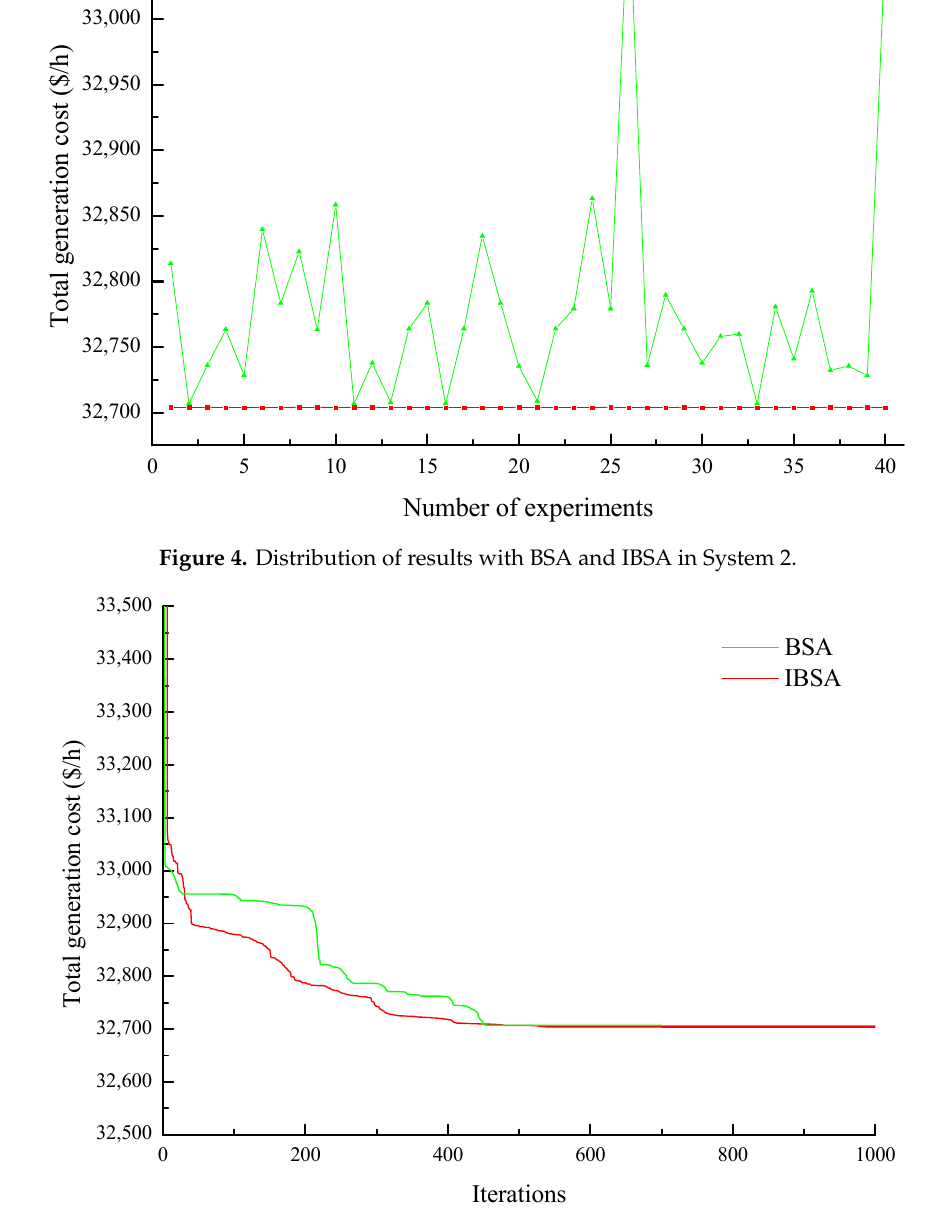
Figure 5. Convergence curve of BSA and IBSA in System 2.